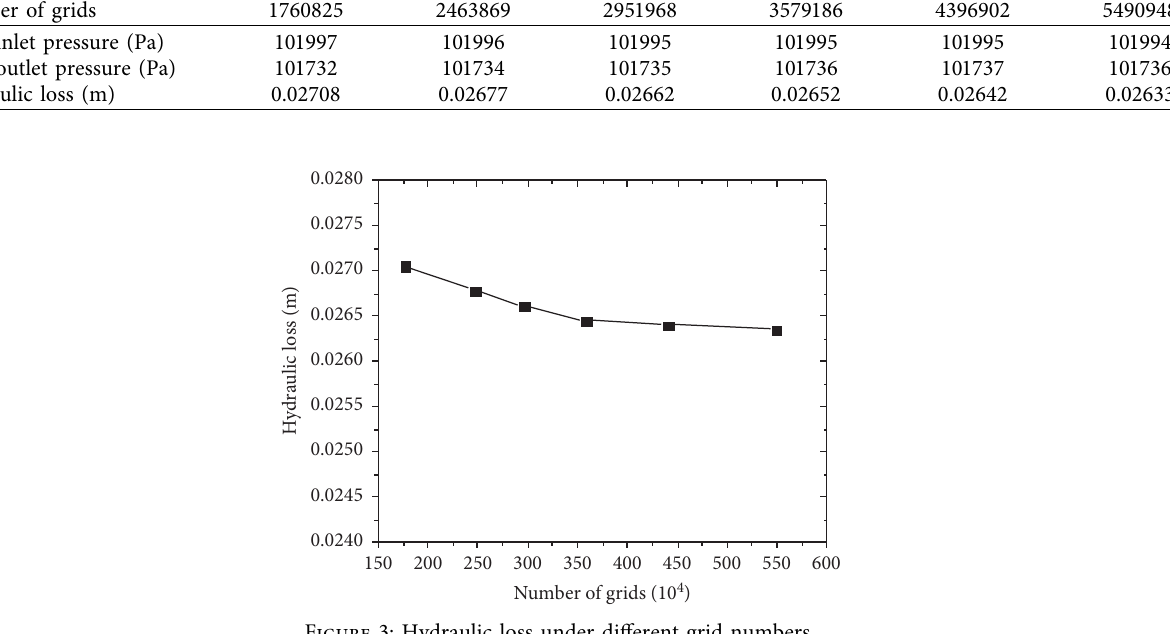
Figure 3: Hydraulic loss under different grid numbers.